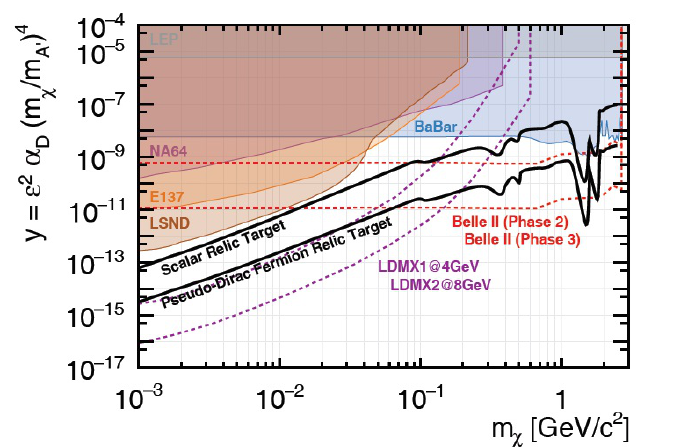
Figure 5. Expected upper limit (90% CLon y = ε 2 α D (where α D is the coupling with the dark sector) for the process where the A (cid:48) decays in DM for a 20 fb − 1 luminosity and for a 50 ab − 1 luminosity. In this plot, α D = 0.5 and m D = m A (cid:48)